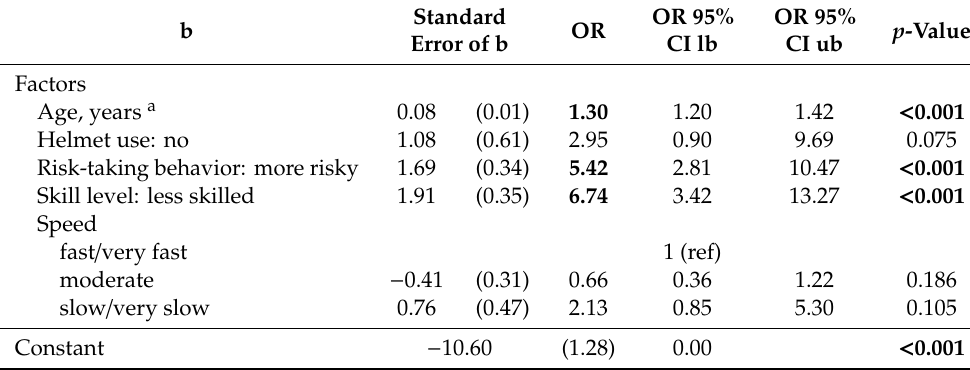
Table 3. Multiple binary regression analysis with ACL injury (0: uninjured, 1: ACL injured) as dependent